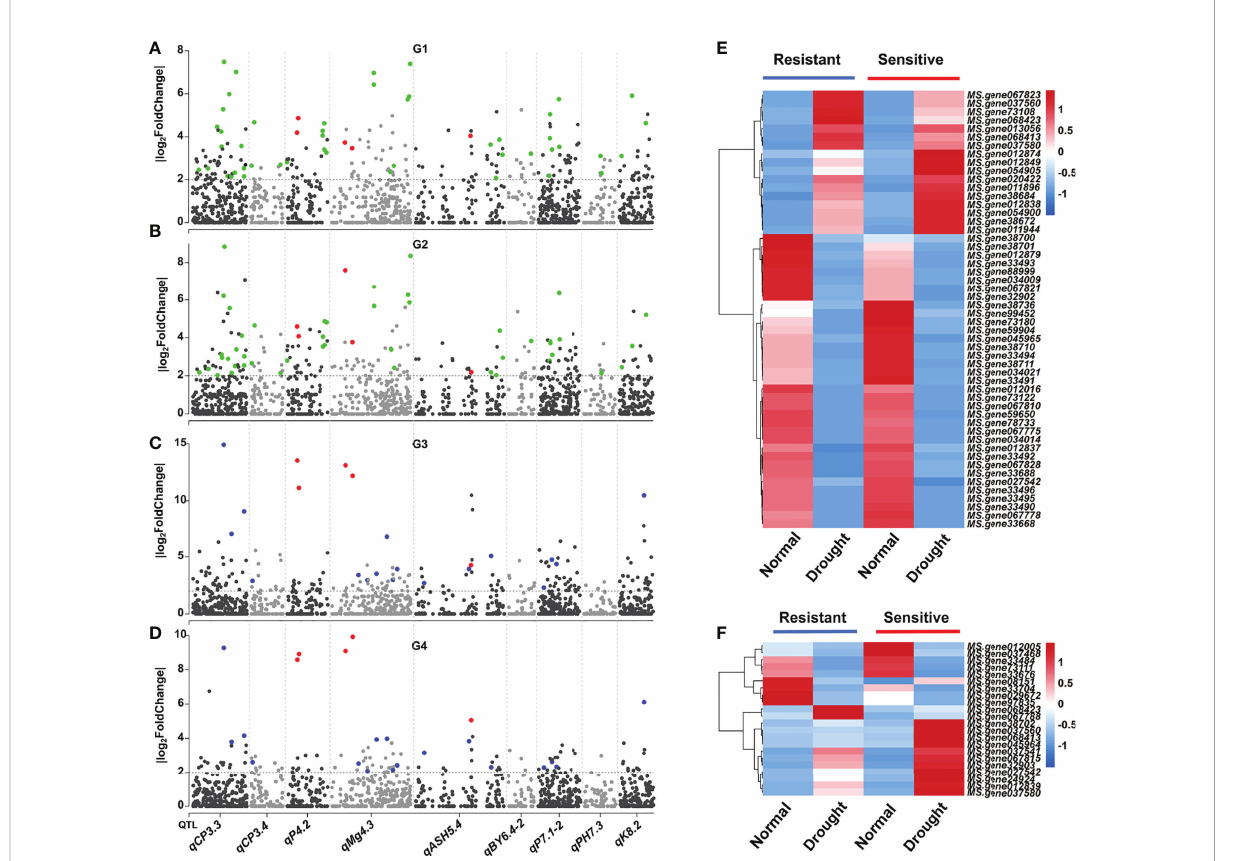
FIGURE 4 Combined transcriptome analysis and linkage mapping revealing the potential causal genes for drought response in alfalfa. (A – D) Distribution of DEGs within nine main QTL regions in four comparative groups, respectively. Green, blue, and red colors represent common DEGs among root, leaf, and four comparative groups, respectively. (E) , Heatmap of 52 common DEGs among root. (F) Heatmap of 22 common DEGs among